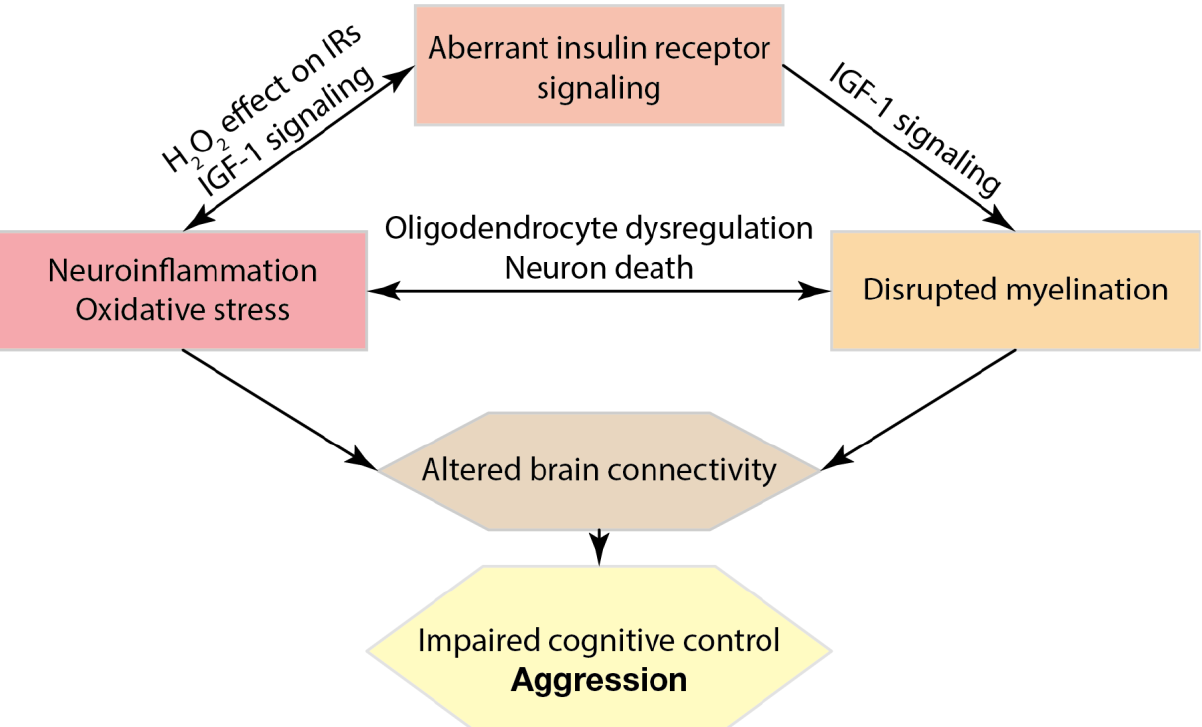
Figure 1. Pathological molecular pathways of neuroinflammation, myelination and insulin receptor signalling resulting in impaired cognitive control and excessive aggression in patients with depression. Major depression disorder and elevated stress response can be accompanied by neu- roinflammation and oxidative stress, which affect brain insulin receptor (IR) signalling and mye- lination. The autophosphorylation of IR was shown to be highly sensitive to H 2 O 2 signalling en- hanced by oxidative stress [187]. It may alter IGF-1 signalling, where IGF-1 has neuroprotective and anti-inflammatory effects [299]. IGF-1 also promotes myelination via IRs on oligodendrocytes [214,216]. Impaired myelination might further trigger neuroinflammation as myelin debris, prod- ucts of neuron elimination, and dysregulation of activity-dependent astrocytes are known to acti- vate microglia and macrophages [300]. In turn, pro-inflammatory cytokines and dysregulation of glia by inflammation negatively affect myelination [301]. Aberrant signal propagation, axon deg- radation and neuronal death due to a lack of metabolic support from myelin sheaths can impair t brain connectivity, resulting in deficient cognitive control, e.g., disruption of cortical-subcortical connections, and thus contributing to excessive aggression.